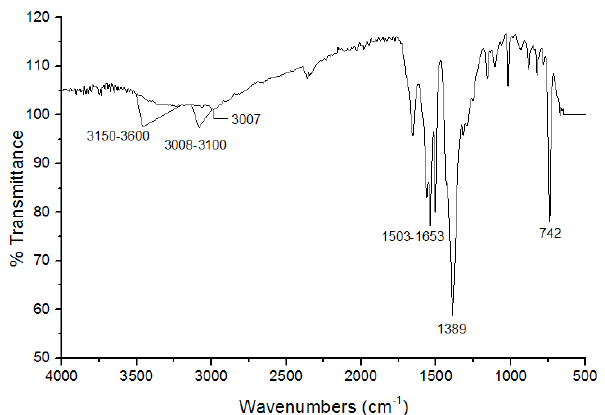
Figure A3. FTIR Spectra of UiO-66 particles in range of 4000–500 cm − 1.